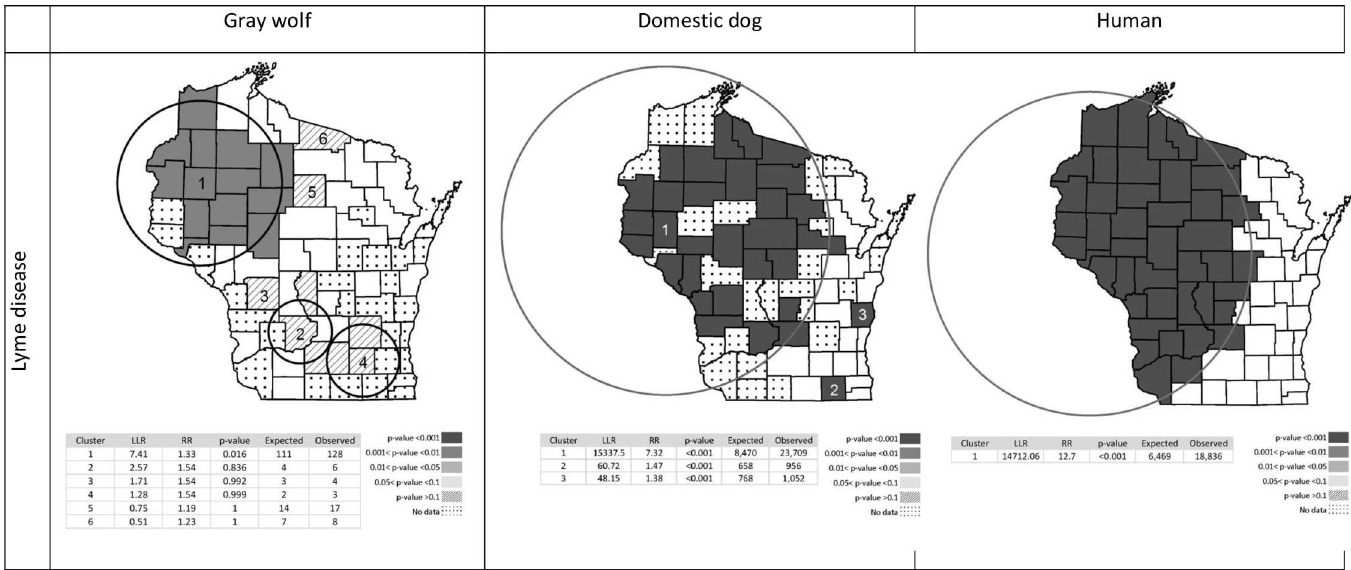
Fig 3. Spatial distribution of clusters of wolf seroprevalence to B . burgdorferi (1985–2011) and domestic dogs (2007–2013), and human cases (1989–2011) in Wisconsin. The maps show the locationand extent of the most likely cluster and secondary clusters of seroprevalence and the counties encompassed by it are shaded.In addition,the log likelihoodratio (LLR), relative risk (RR), significance(P-value), expectednumberof cases (Expected) and observednumber of cases (Observed) are shownfor each cluster.